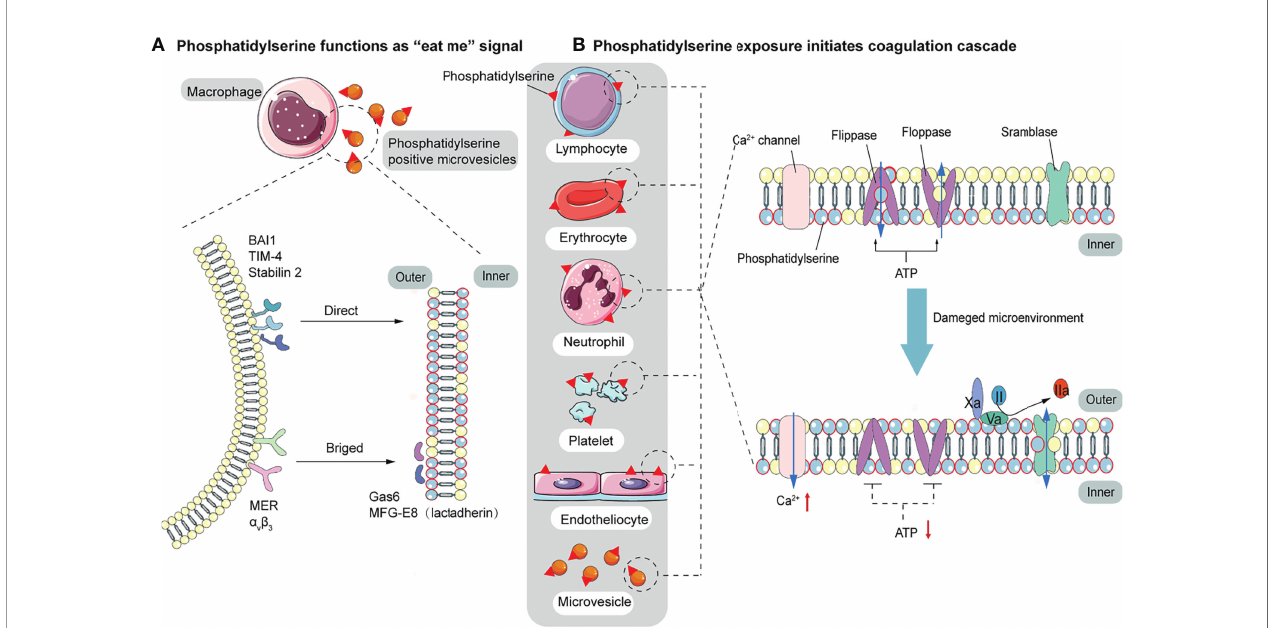
FIGURE 2 | The function of PS. (A) PS acts as a signal to be engulfed by macrophages with two recognition modes. One is directly recognized by phagocytic receptors BAI1, TIM-4, and Stabilin 2. The other is indirect recognition. The bridging molecules MFG-E8 (also known as lactadherin) and GAS6 bind to PS, which is recognized by membrane proteins MER and a V b 3 . These two recognition patterns are not mutually exclusive and may co-occur. (B) PS provides a negatively charged surface to initiate and maintain coagulation. In normal conditions, PS is sequestered in the inner layer of cell membranes by the action of fl oppase and fl ippase. When intracellular Ca 2+ increases, the ATP-dependent translocation enzyme is blocked, and the scramblase is activated, resulting in a random distribution of PS to both sides of the membrane. PS, initially located in the cell ’ s inner membrane, is exposed to the outer side. On the outer membrane, PS provides active clotting catalytic surfaces for forming TF-FVIIa complex, factor X-enzyme complex (FIXa-FVIIIa-Ca 2+ -PL), and prothrombinase complex (FXa-FVa-Ca 2+